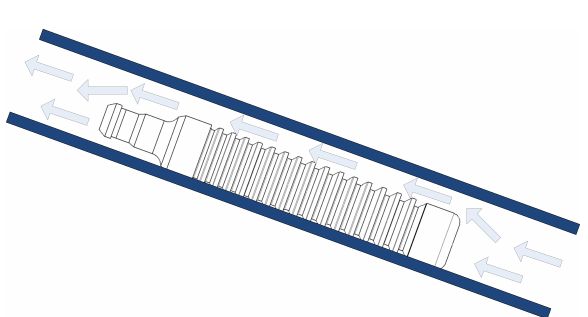
Fig. 2. Structural diagram of plunger for conventional vertical well.